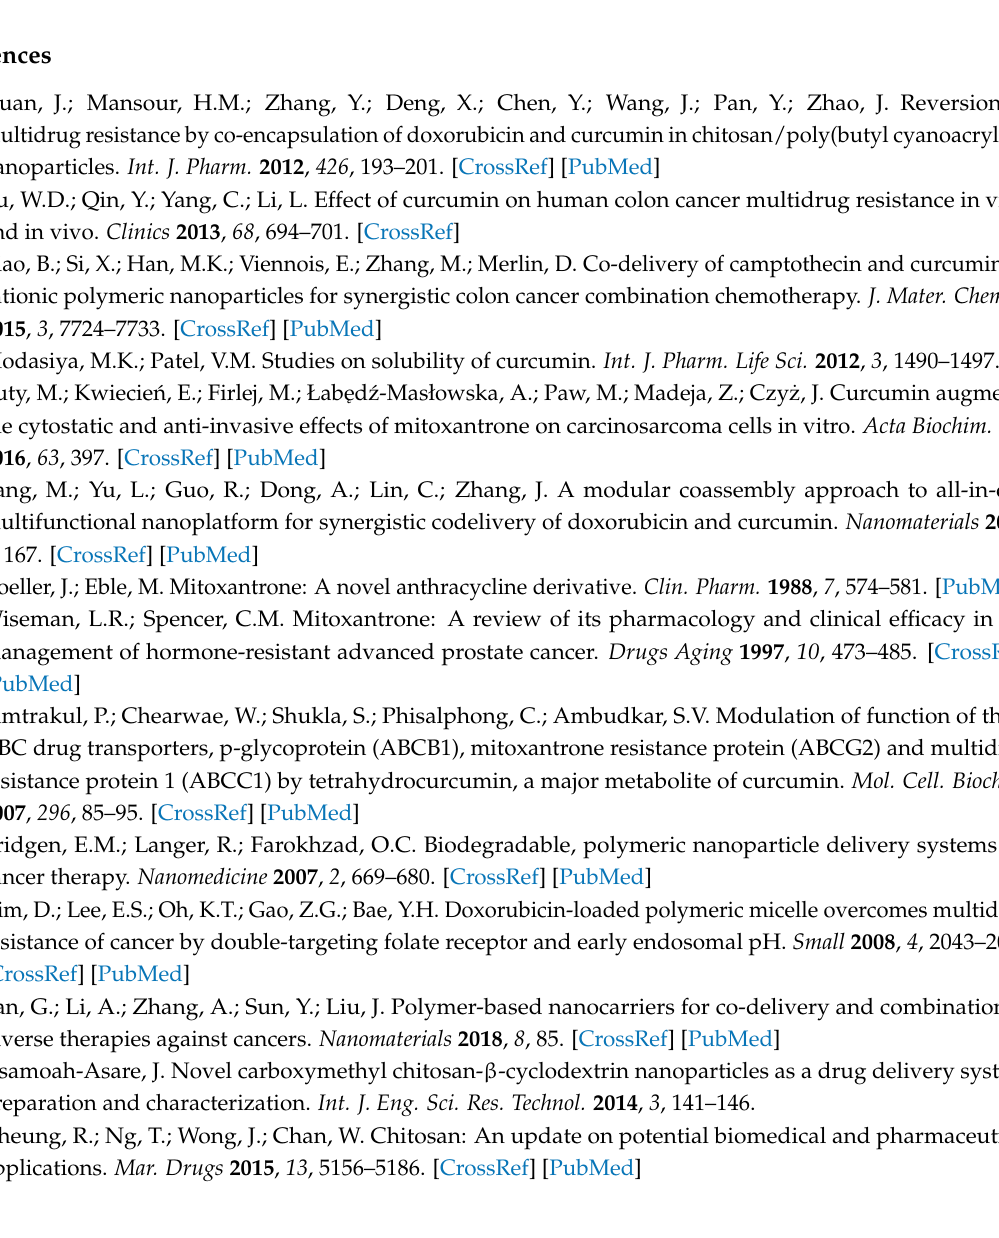
Table S1: Supplemental data for calculating the combination index, Table S2: Data for plotting the